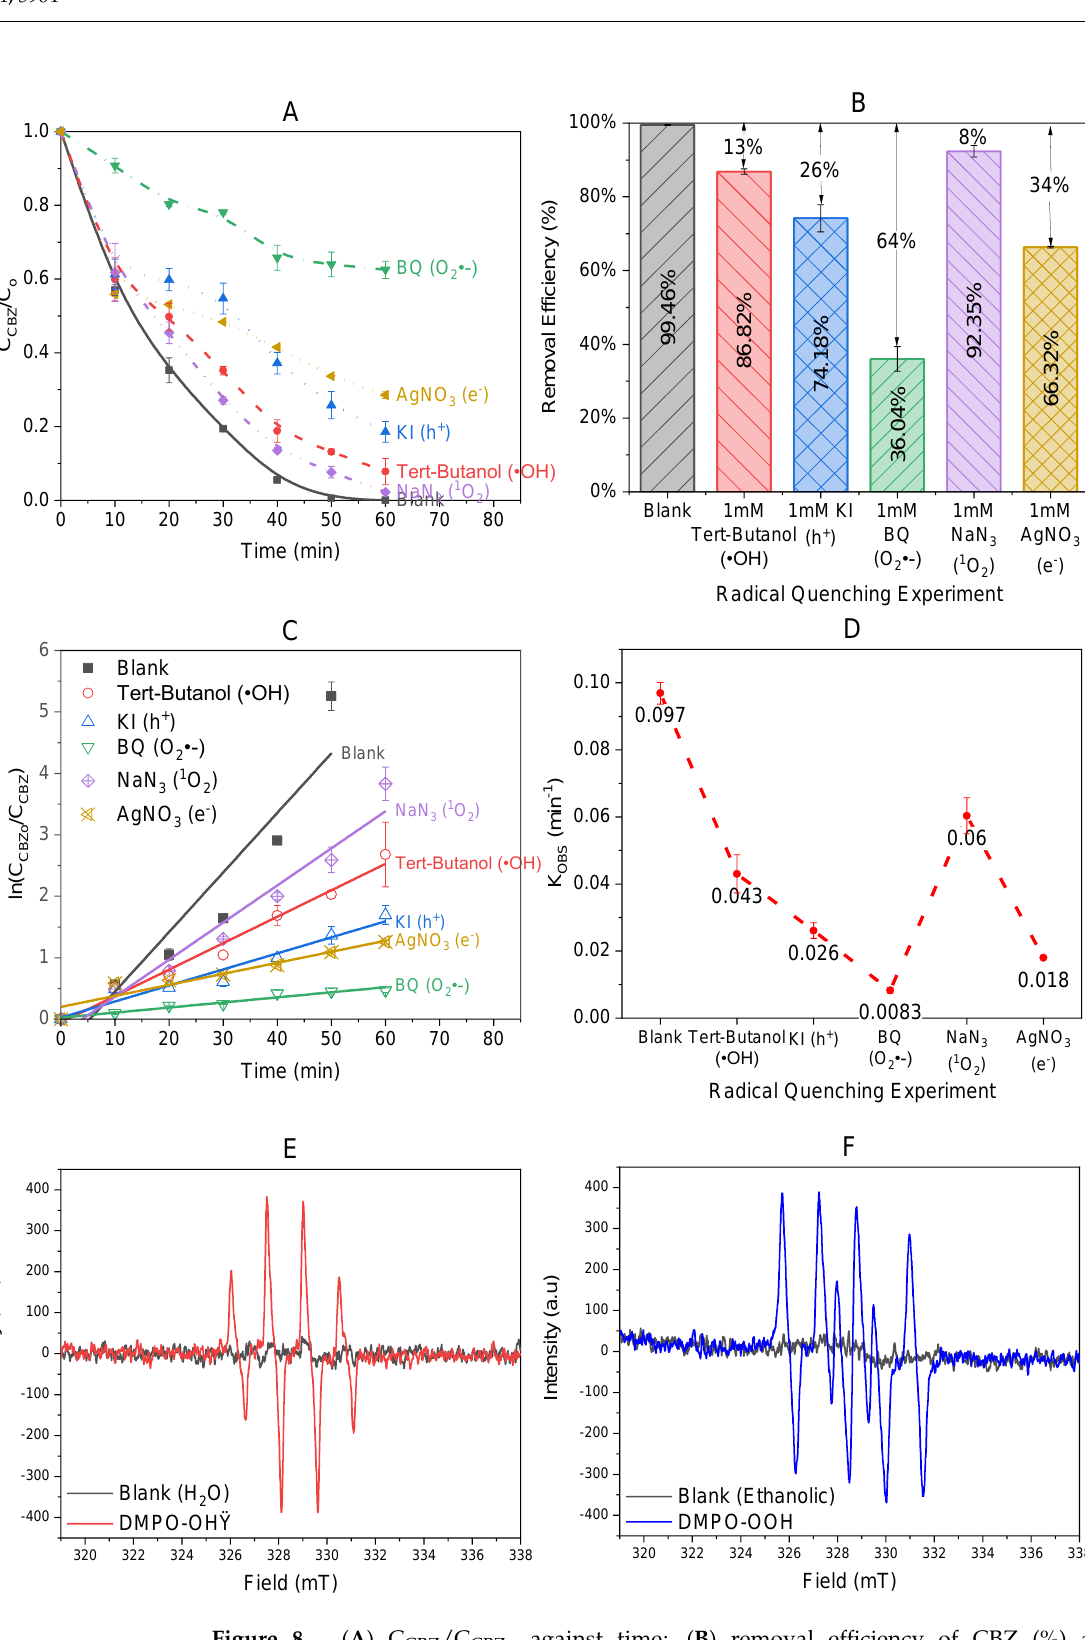
Figure 8. ( A ) C CBZ /C CBZo against time; ( B ) removal efficiency of CBZ (%) at 50 min; ( C ) ln(C CBZo /C CBZ ) against time; ( D ) degradation rate constants, min −1 due to the effects of different scavengers (MIL − 101(Cr)@TiO 2 composite = 2 g/L, CBZ = 10 ppm, UV − A intensity = 36.6 mW/cm 2 ); and ESR spectra of ( E ) DMPO − OH against dark state and ( F ) DMPO − OOH against dark state (DMPO = 100 mM, MIL − 101(Cr)@TiO 2 = 2 g/L).